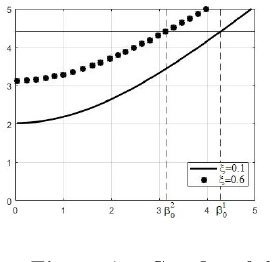
Figure 8. Grapfics of the function f ( β,ξ ) for ξ = 0 . 6. If γ 2 > γ 1 , then β 2 < β 1 . 0 0